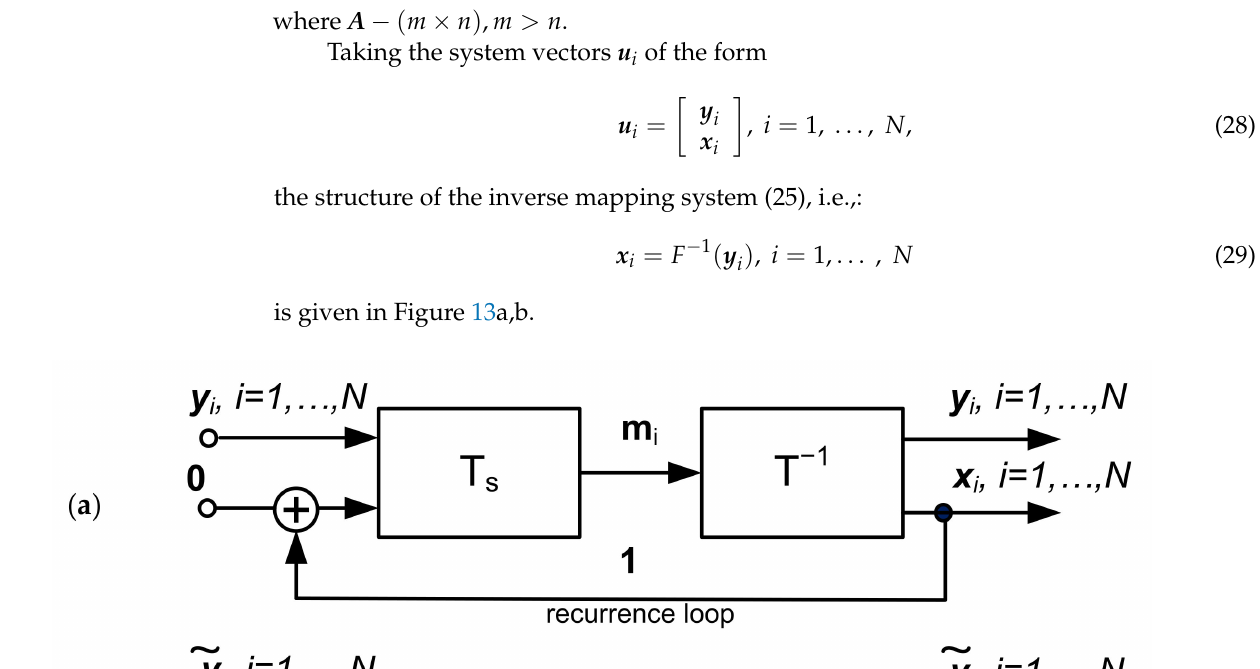
—undegenerated i